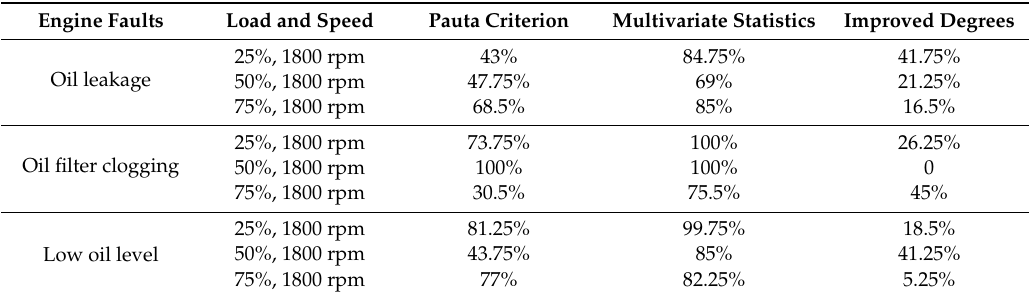
Table 5. The improved performance of engine fault detection rate by using multivariate statistics.